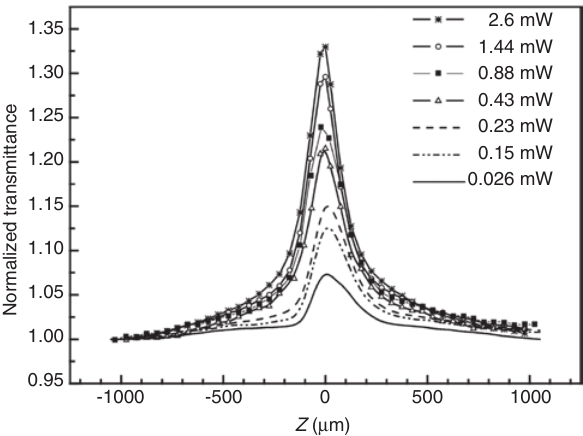
Figure 8: Typical transmission as function of displacement in open aperture Z -scan measurements